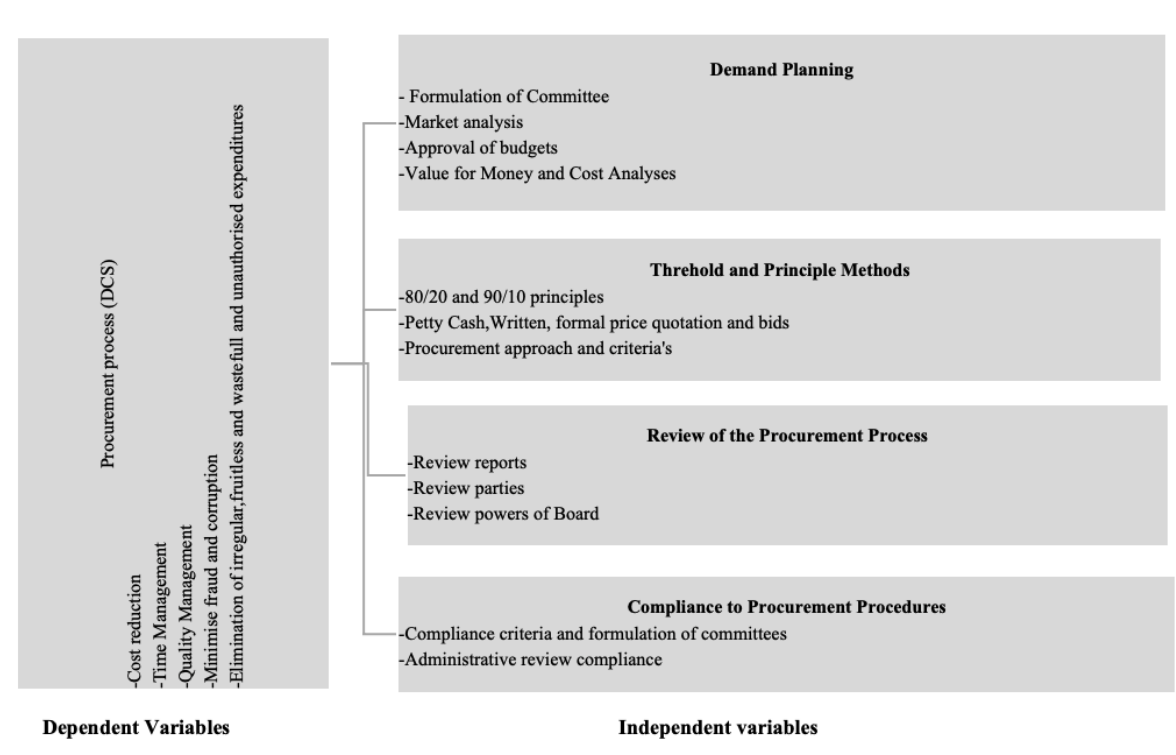
Figure 1: Procurement process and its challenges; Source: Jones